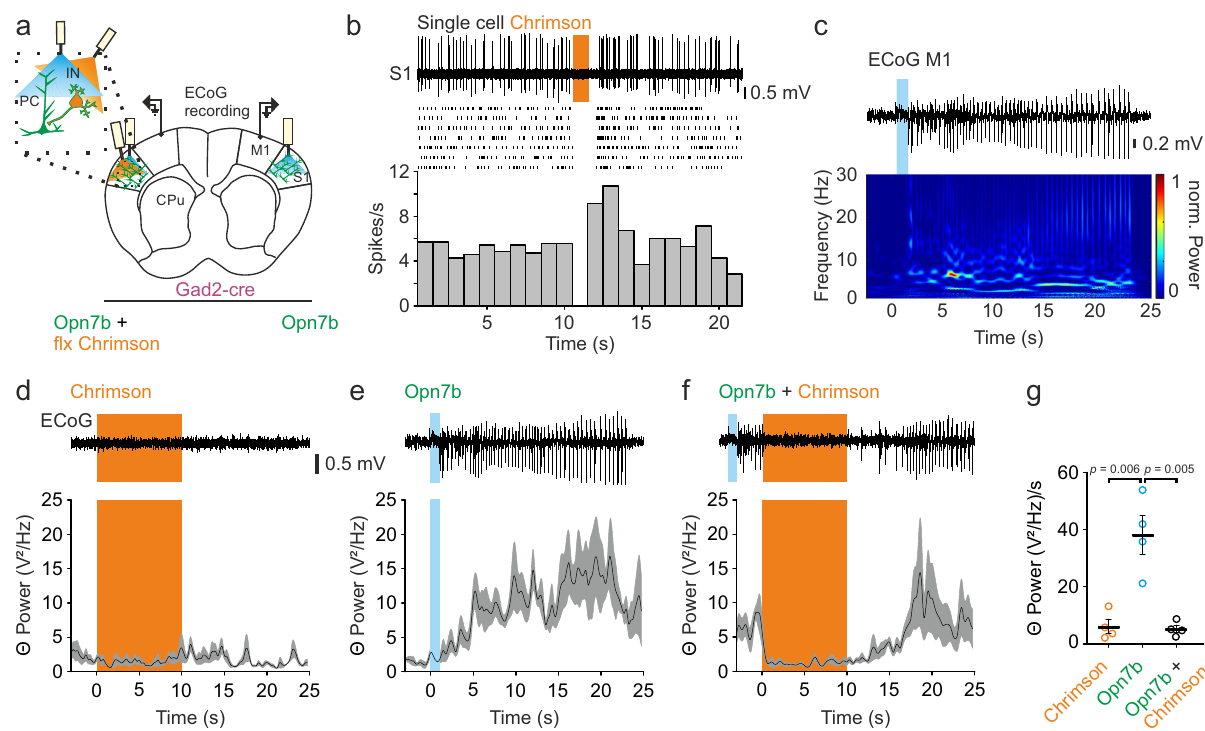
Fig. 6 Bilateral suppression of epileptiform activity by unilateral excitation of inhibitory interneurons. a Schematic example of bilateral electrocorticographic (ECoG) recording, bilateral injection and stimulation site for Opn7b (green) and unilateral injection and stimulation site for fl oxed ( fl x) Chrimson (expression only in GABAergic interneurons, due to Gad2-cre animals, orange). Pyramidal cell (PC); Interneuron (IN); Primary somatosensory cortex (S1); Primary motor cortex (M1); Caudate putamen (CPu). b Representative example of single-cell activity of a putative PC in S1 during Chrimson stimulation of GABAergic interneurons with orange light (620 nm, 1 s; top) and corresponding raster plot (middle, 7 Trials from 1 cell) as well as peri-stimulus time histogram. Bin size 1 s. c Spectral characteristics of generalized epileptiform activity (EA) induced by Opn7b stimulation showed increased activity in the theta frequency band (4 – 8 Hz). d Change in mean theta power in the M1 after 10 s orange light or ( e ) 1 s blue light (465 nm) stimulation. Blue light stimulation induced generalized EA which was detectable by the increase in theta power. The top panel shows a representative ECoG trace example. f Mean theta power was bilaterally decreased (depicted is the contralateral side of Chrimson stimulation) during excitation of GABAergic interneurons in S1 if an EA was induced by 1 s blue light stimulation. For ( d – f ) bottom black line represents mean ( n = 4) while gray area represents the ±SEM. g Mean theta power during 5 s of activity during orange light stimulation (no EA, n = 4), blue light stimulation (EA, n = 4) and orange light stimulation ( n = 4) during EA (Chrimson during EA). Mean theta power during Opn7b alone was signi fi cantly higher than Chrimson alone and if Chrimson was activated after EA onset (one-way repeated measure ANOVA followed by pairwise Bonferroni test F (2,6) = 18.262, p = 0.003). Each circle represents individual animals, while the bar represents the mean value for all animals. Error bars represented as ±SEM. Source data are provided as a Source Data fi